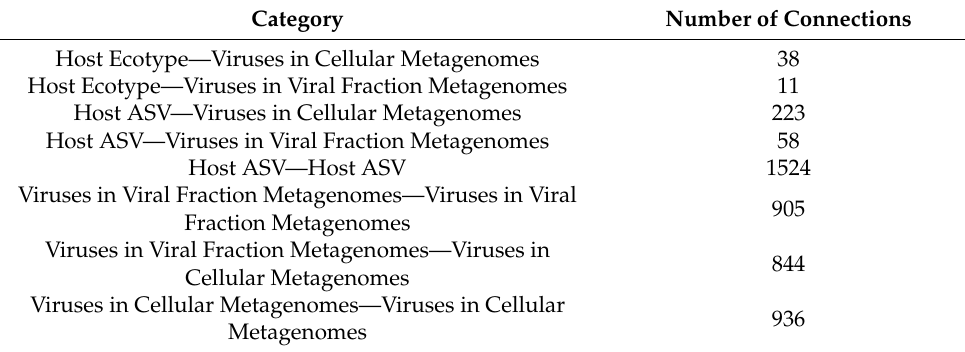
Figure 6. Network analysis of cyanophages and cyanobacteria. The network depicts correlations among viral species in viral fraction and cellular fraction metagenomes, host ASVs, and ecotypes as determined by eLSA with only strong and significant (Q < 0.05, ρ ≥ 0.6, Spearman correlation) interactions shown. The fill color of phage species indicates the dynamic class to which they belong, and if seasonal, the color indicates the month that they are predicted to be most abundant by the GAMM. For other dynamic classes (sporadic, persistent, or occasional), the outline color indicates the month at which they were most abundant. Table 1. Number of significant host–virus and virus–virus relationships identified by eLSA time series